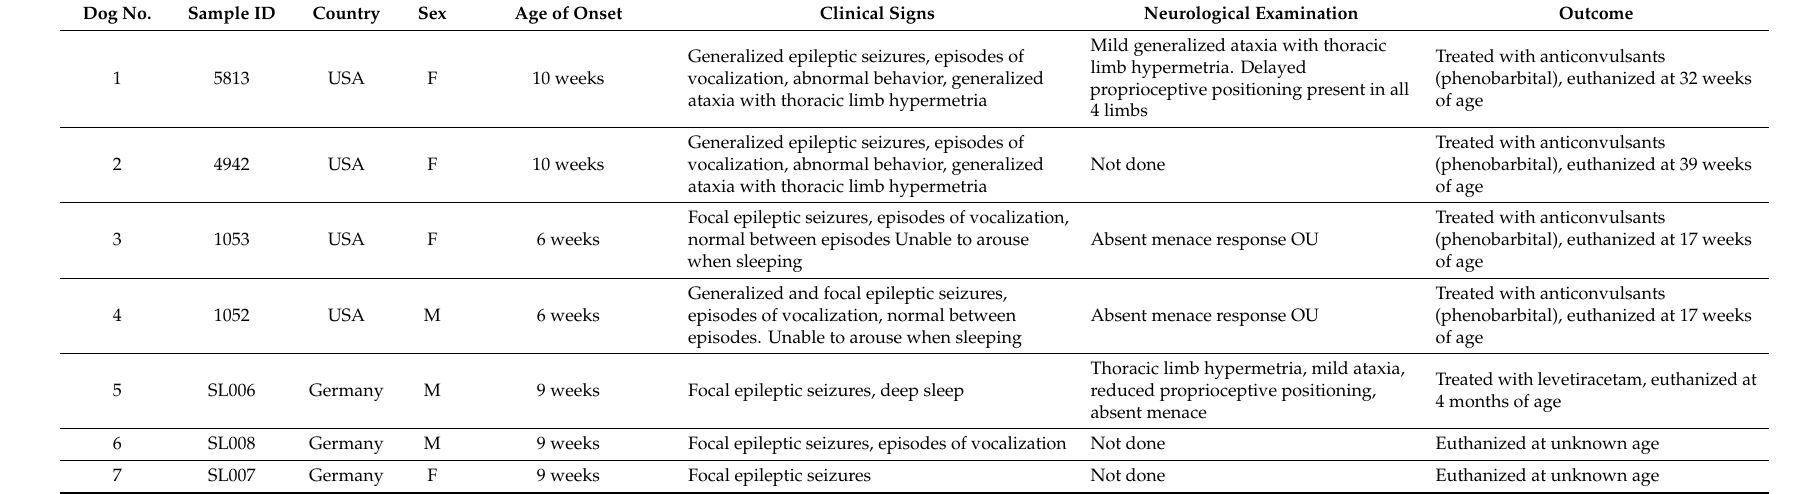
Table 1. Clinical information for seven SSADHD-a ff ected Saluki dogs. (OU = oculus uterque (both eyes)). Dog